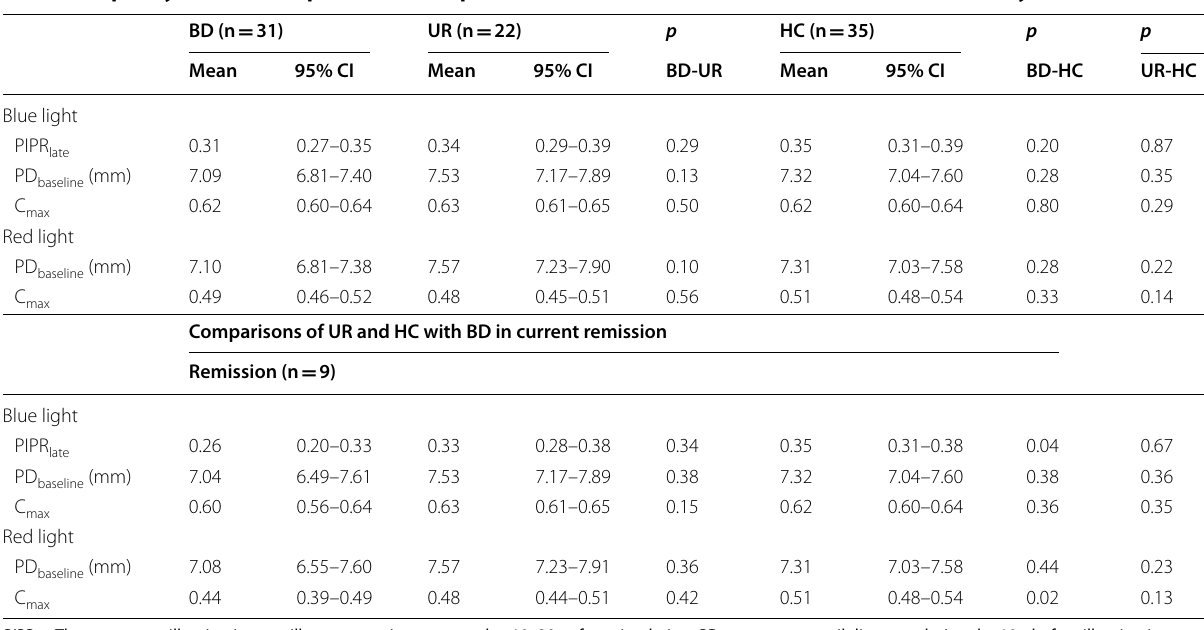
Table 2 Pupillary outcomes in persons with bipolar disorder (BD), unaffected relatives (UR) and healthy controls